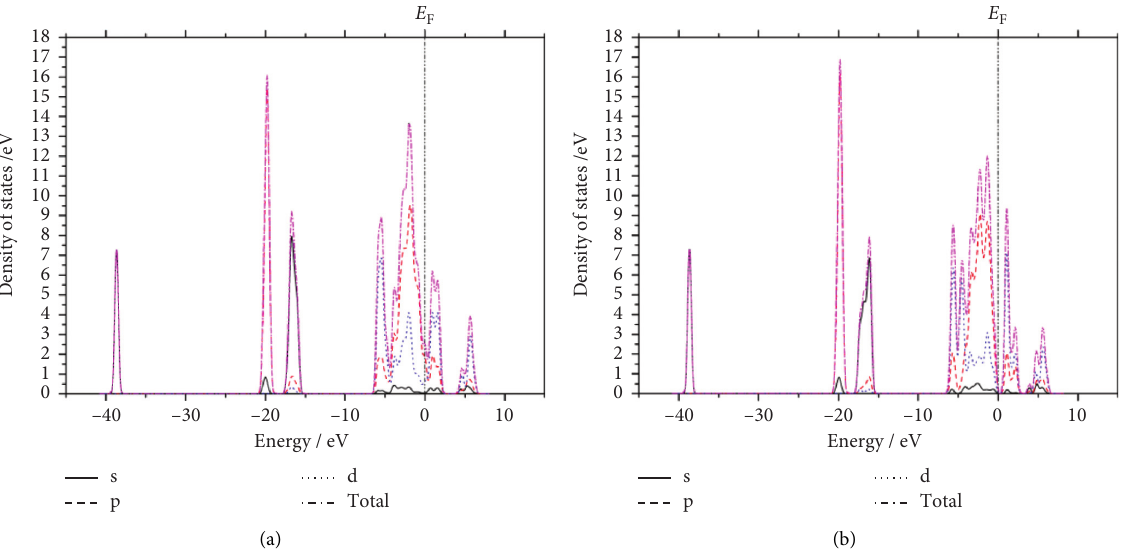
Figure 5: Electron density of states of sandwiched Ca 2 Co 2 O 5 crystalline oxide for (a) spin-up and (b)